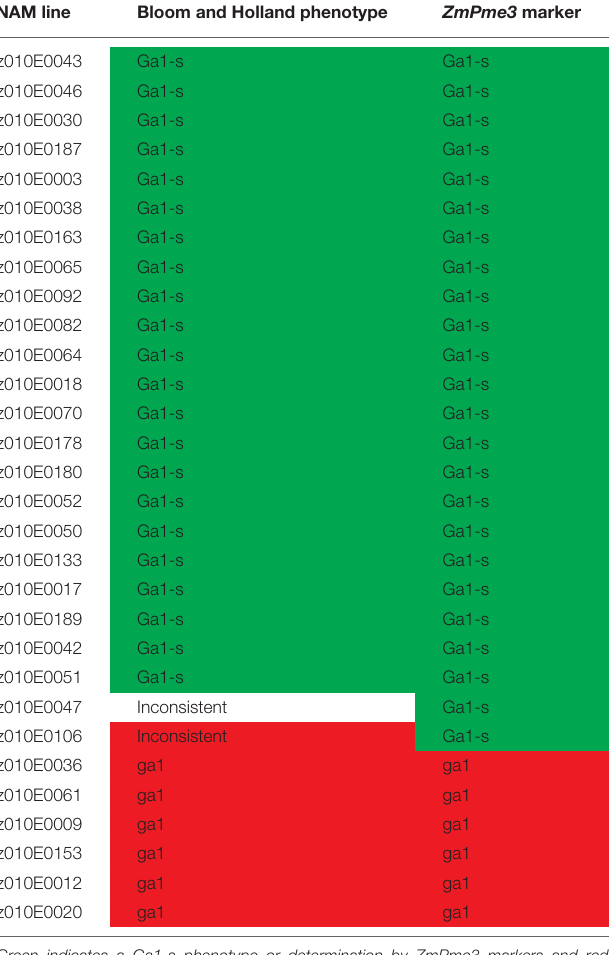
TABLE 2 | Mapping ZmPme3 to chromosome 4 using the NAM Hp301 × B73 lines that were used to determine the ga1 locus (Bloom and Holland,